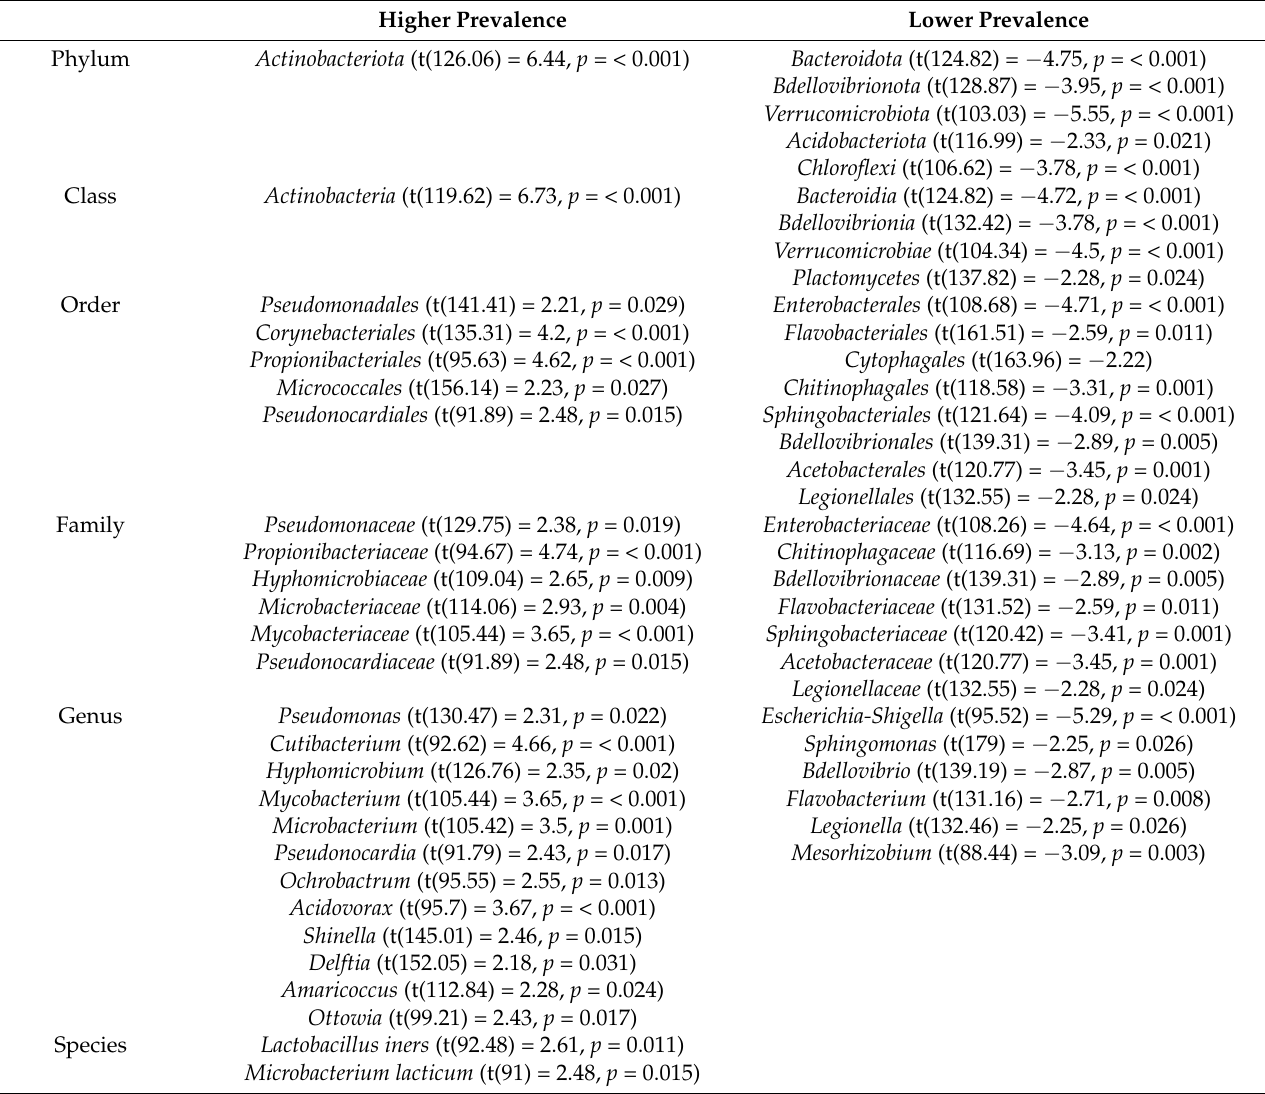
Table 1. Prevalence of taxa when sequenced with primer pair V1–V2 compared to V3–V4. Higher Prevalence Lower